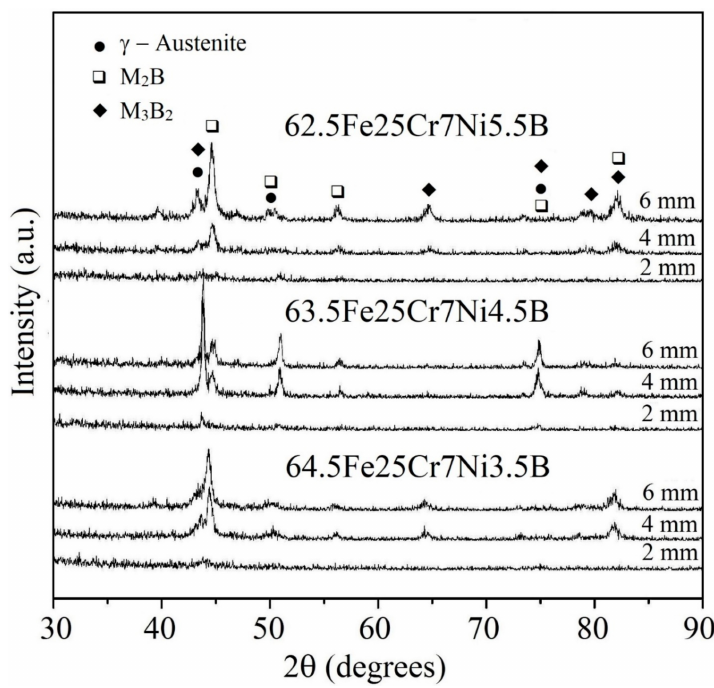
Figure 3. XRD patterns of 68-xFe25Cr7NixB (x = 3.5, 4.5, and 5.5 wt.%) alloy sections extracted from different sample